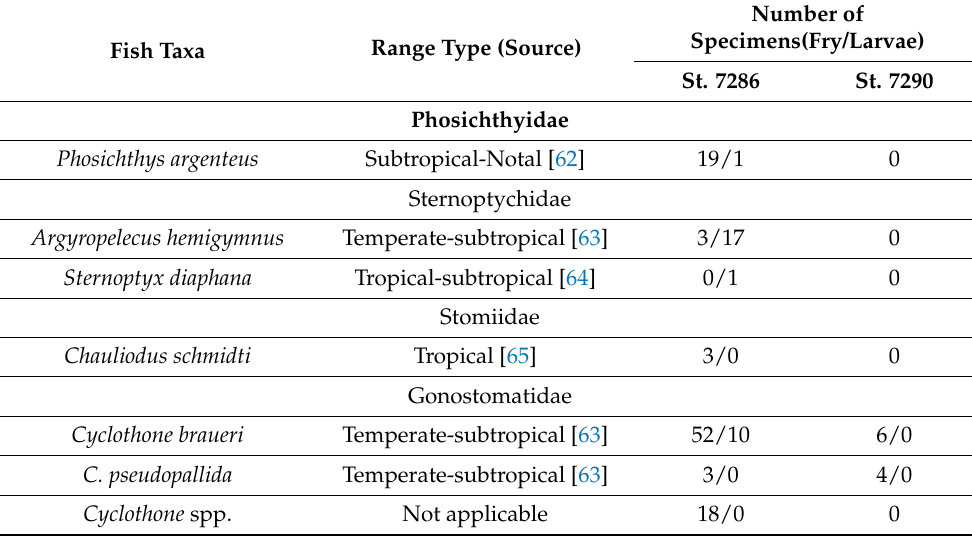
Table 2. Species composition of ichthyoplankton at different